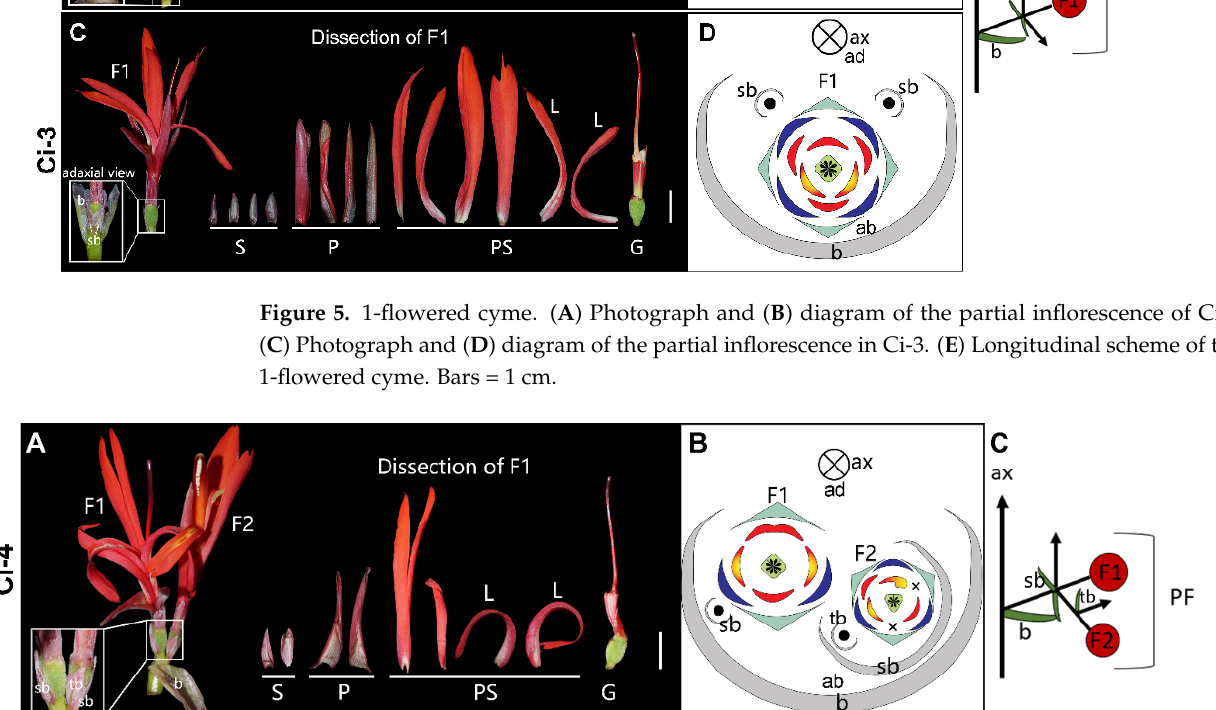
Figure 5. 1-flowered cyme. ( A ) Photograph and ( B ) diagram of the partial inflorescence of Ci-2. ( C ) Photograph and ( D ) diagram of the partial inflorescence in Ci-3. ( E ) Longitudinal scheme of the 1- flowered cyme. Bars = 1 cm. Figure 6. 2-flowered cyme. ( A ) Photograph and ( B ) diagram of the partial inflorescence of Ci-4. ( C ) Longitudinal scheme of the 2-flowered cyme. Bar = 1 cm.